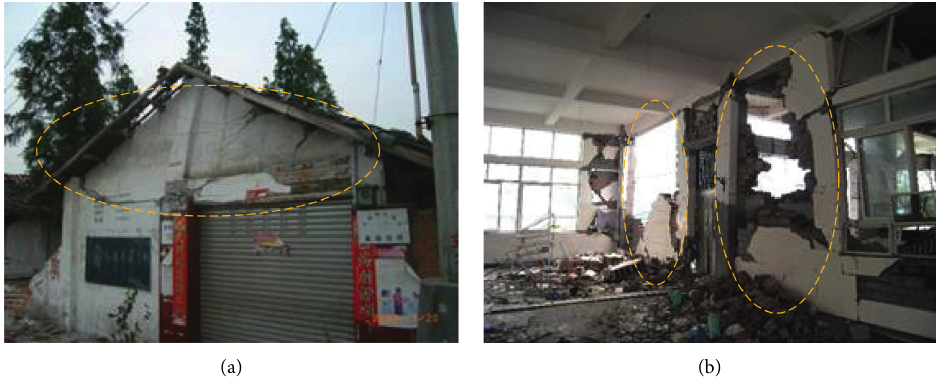
Figure 1: Out-of-plane failure of walls (Wenchuan earthquake, May 12,